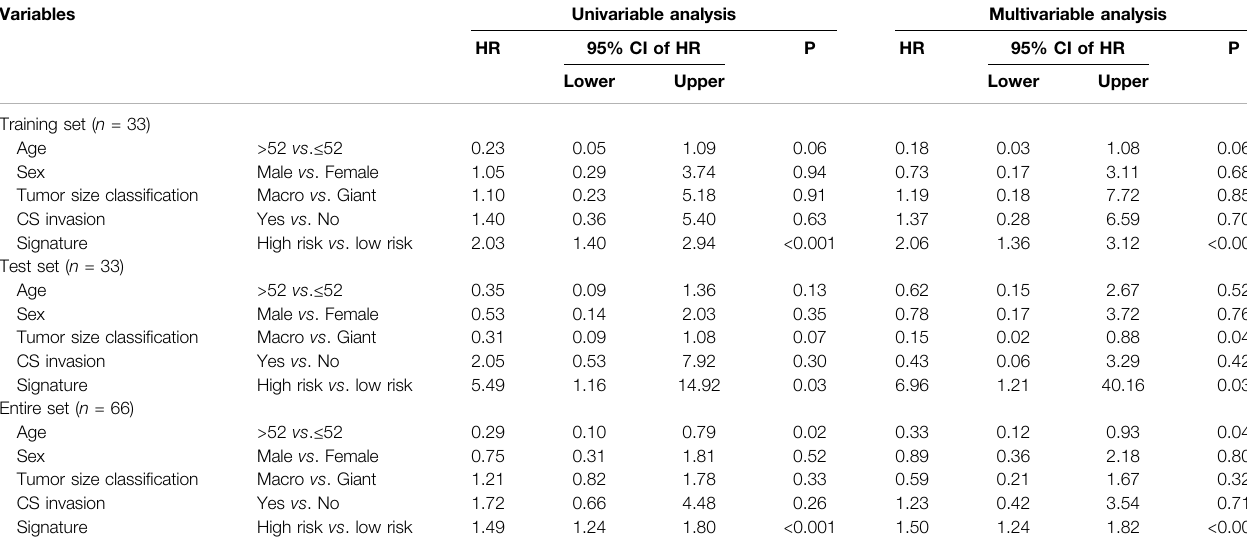
TABLE 4 | Univariable and multivariable Cox regression analysis of the signature and survival of NFPA patients in the training, test group and entire group.